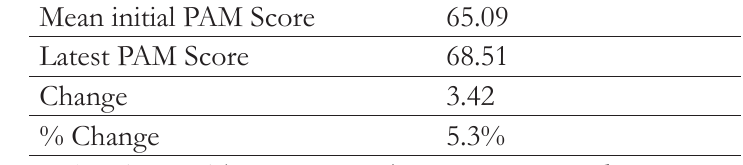
Table 4. Intervention Group Change in Patient Activation Measures